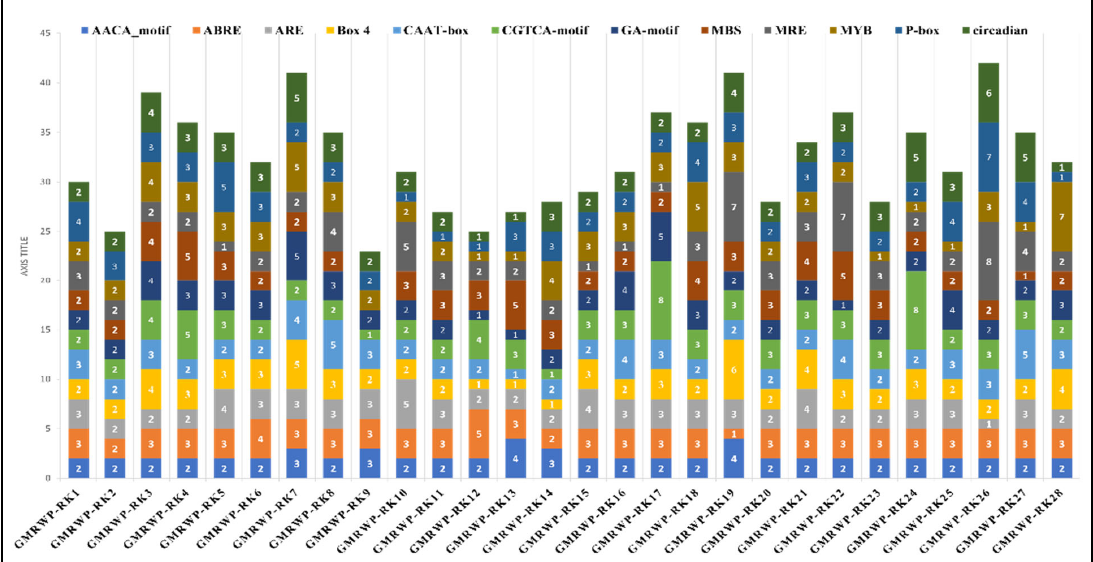
Figure 4. The distribution of cis-acting elements of GmRWP-RK genes in soybean. The illustration of boxes of different colors shows the occurrence of different cis-regulatory elements within the promoter region of GmRWP ‐ RK genes.